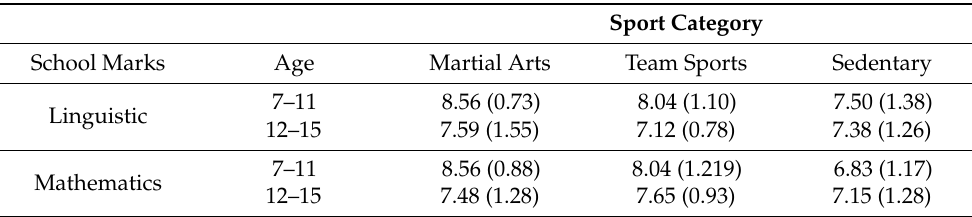
Table 4. School marks in linguistic and mathematics for the three-sport categories: martial arts, team sport, and sedentary.